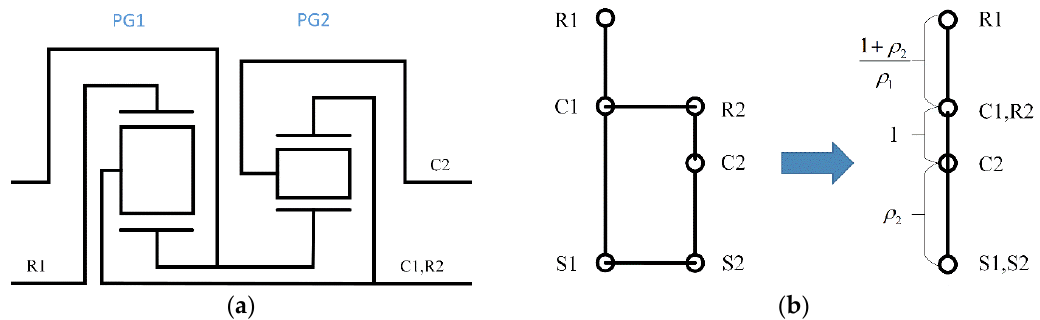
Figure 3. ( a ) Simpson automotive transmission configuration; and ( b ) combined lever diagram, where Z R 2 Z R 1 ρ , ρ 2 “ . 1 “ Z S 1 Z S 2